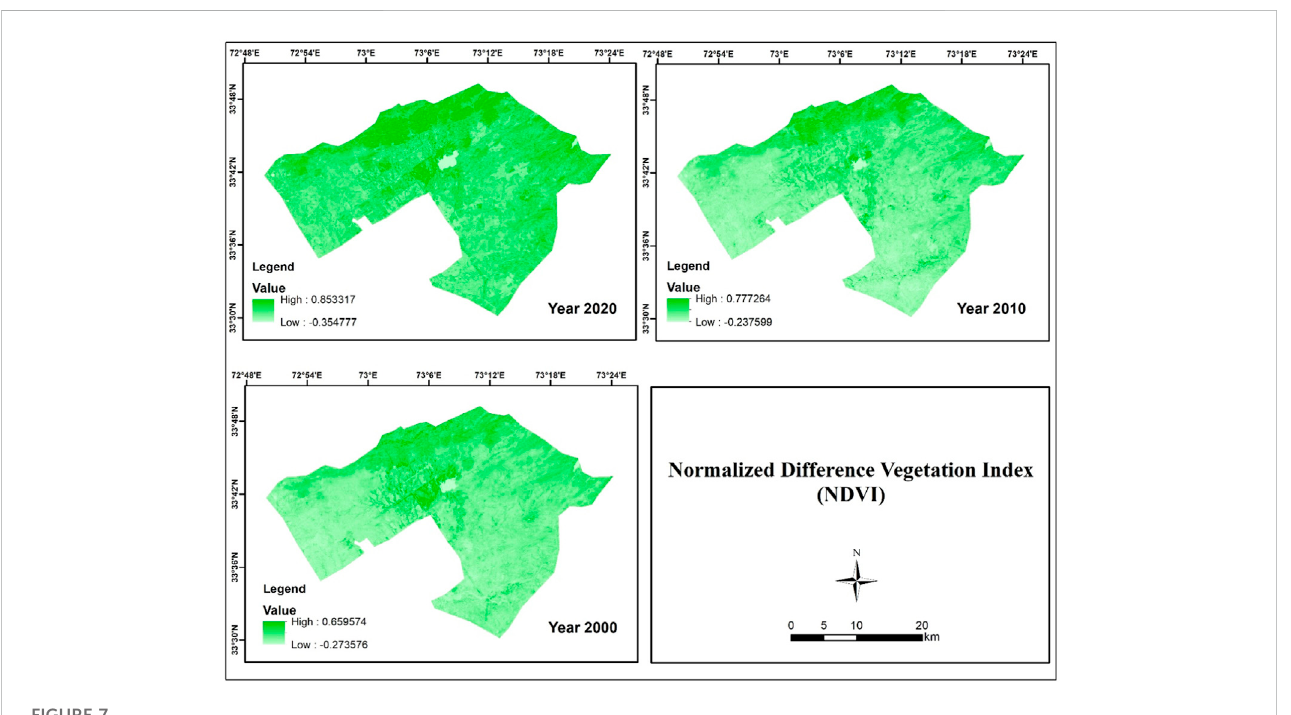
FIGURE 7 NDVI comparison map for the years 2000, 2010, and 2020.